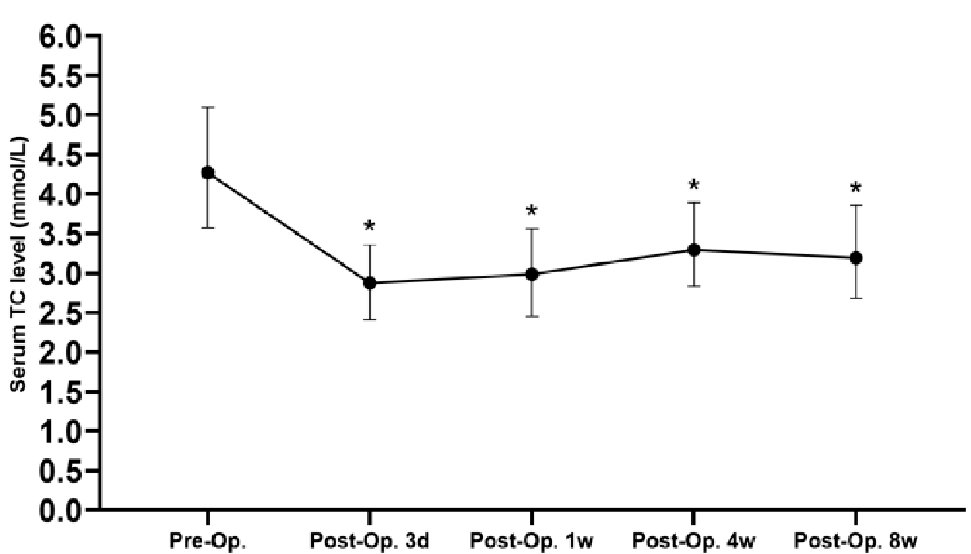
Figure 3. The variation tendency of serum TC perioperatively (*: compared with preoperative TC, p < 0.05, TC: total cholesterol, Preop.: preoperation, Postop.: postoperation).